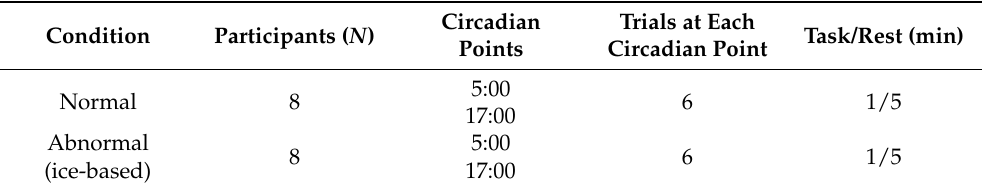
Table 6. Data collection for Experiment 3: two conditions, eight participants, two circadian points, and six trials at each circadian point.